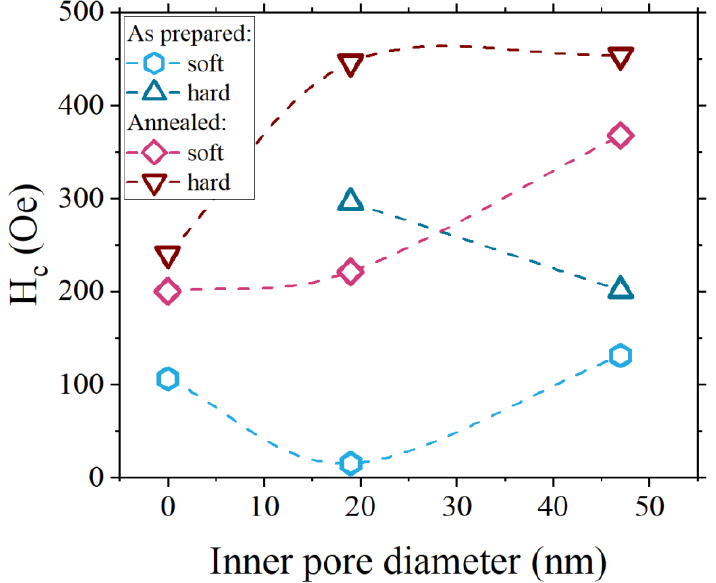
Figure 6. The 10 K coercive field of both magnetic phases with respect to the inner pore diameter.